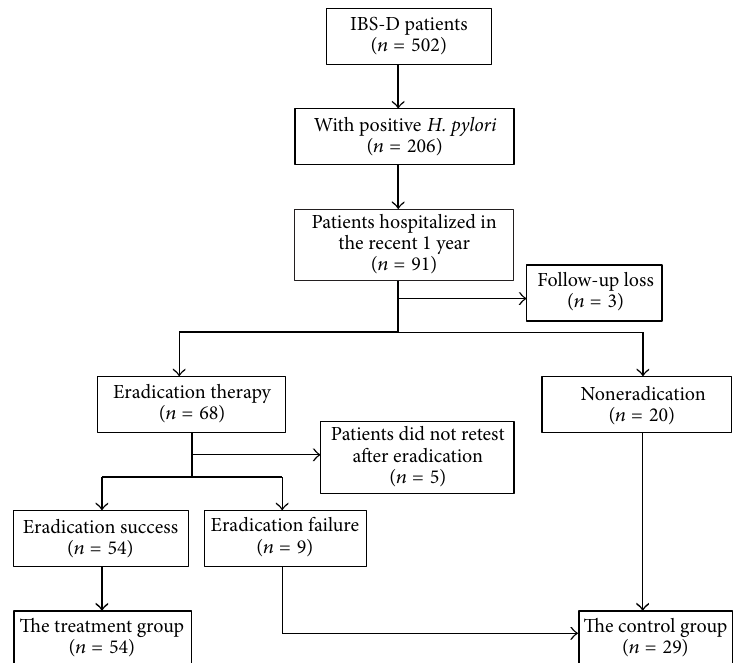
Figure 1: Flow chart of the analyses performed in this study. IBS-D: diarrhea-predominant irritable bowel syndrome; H. pylori : Helicobacter pylori